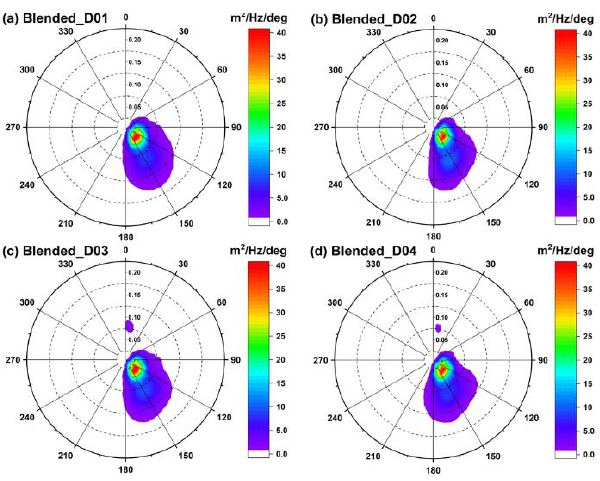
Figure 19. Comparison of the directional wave spectra at the Eluanbi wave buoy at 00:00 on 14 September 2016, using the four computational domains ( a – d ) and blended wind fields.